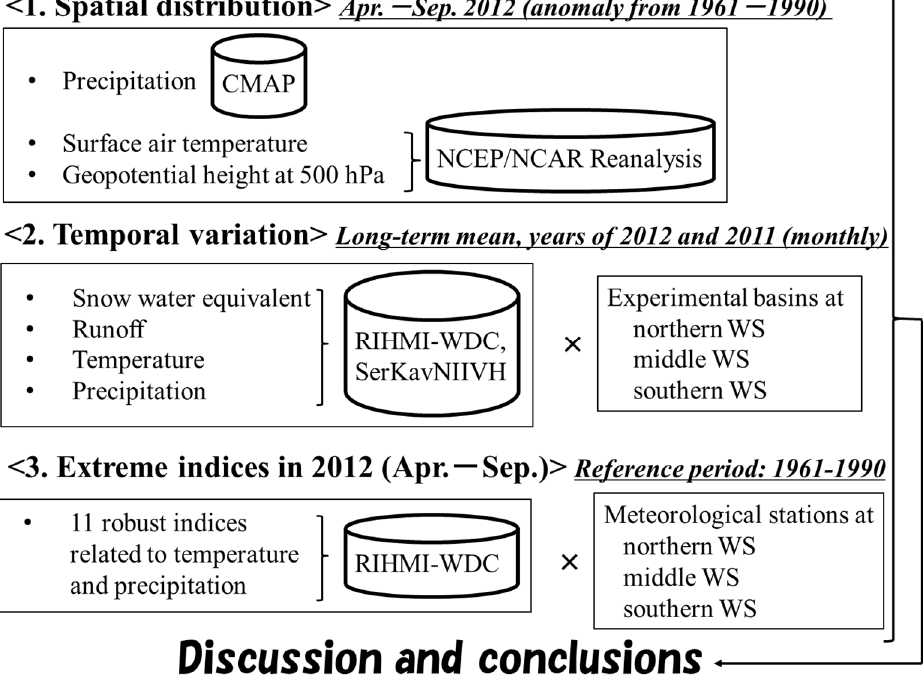
Figure 3. A flowchart of the research procedure of the present study. For the acronyms, refer to Section 2 and references.